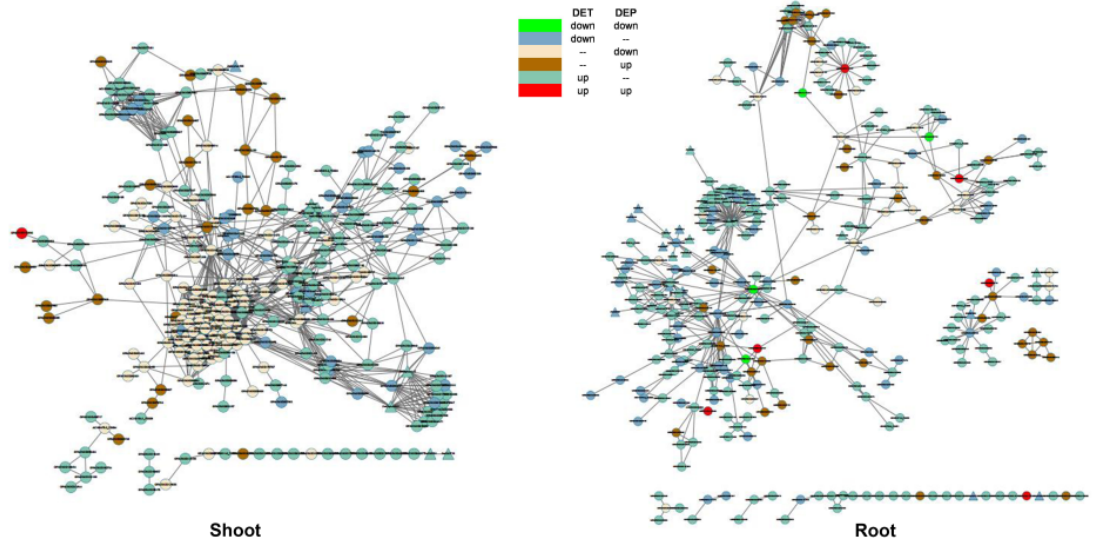
Figure 4. Protein interactions of differentially expressed genes in shoot and root.